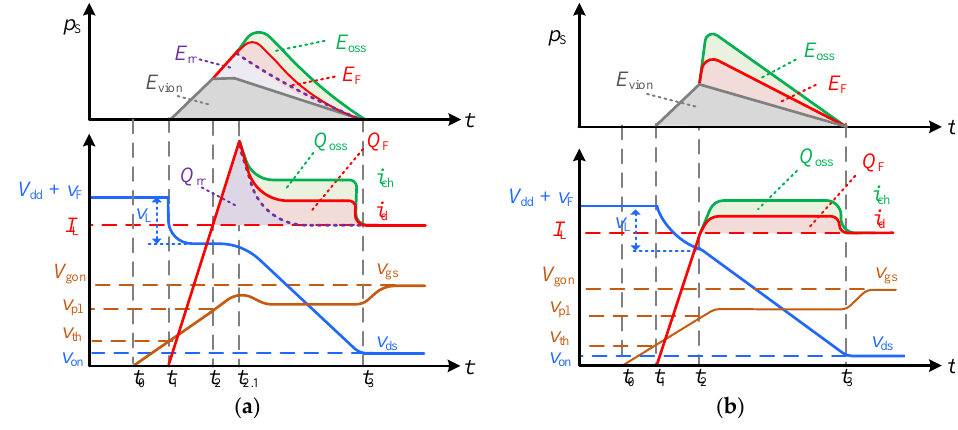
Figure 3. Typical turn on waveforms for 𝑆 with 𝐷 ( a ) PIN or body diode; ( b ) SBD or eGaN HEMT.